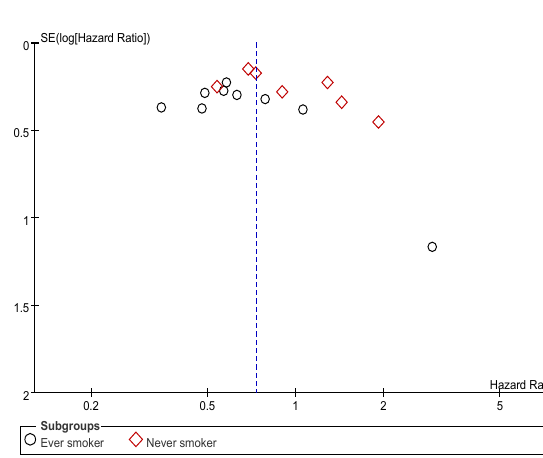
Figure A4. PFS comparisons stratified by smoking status.